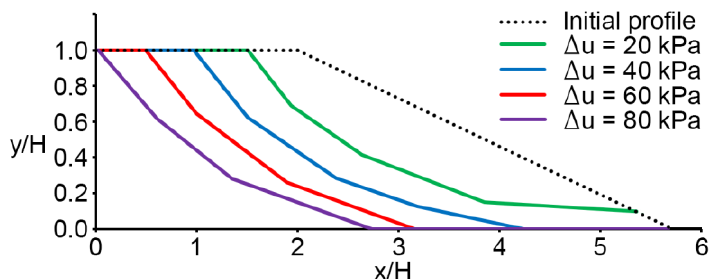
Figure 10. Location of the slip surface in dimensionless coordinates, for the case with α = 15°, φ’ = 35° , and different values of Δu.